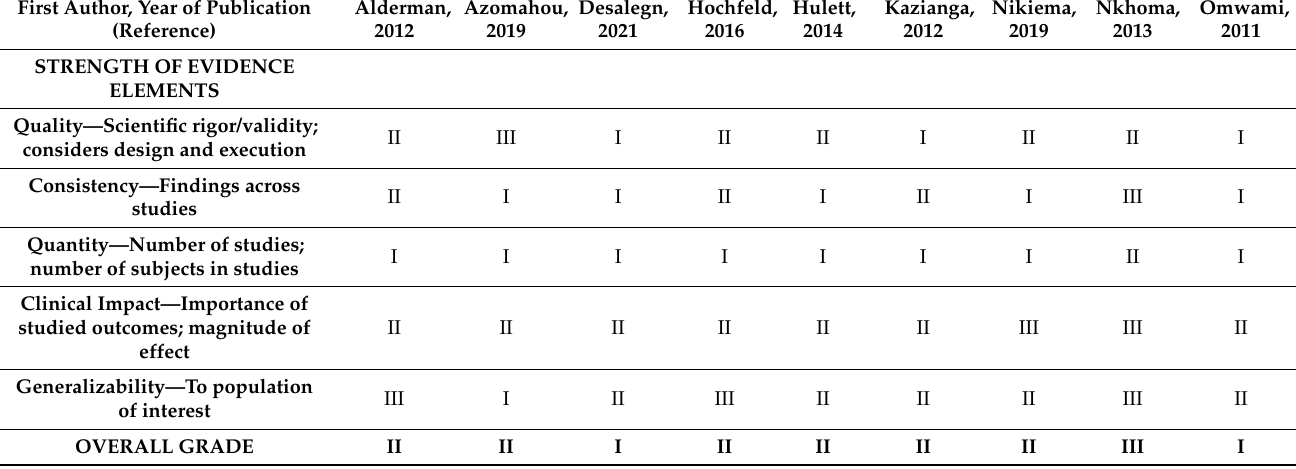
Table A2. Quality